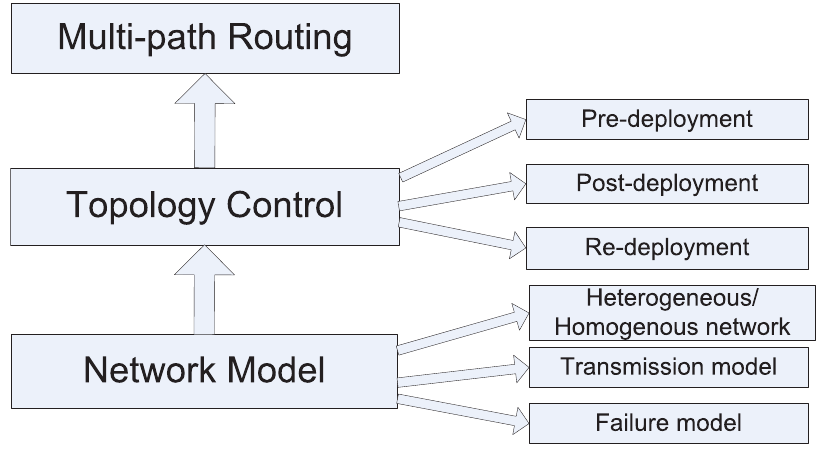
Figure 1. Resilient WSN design